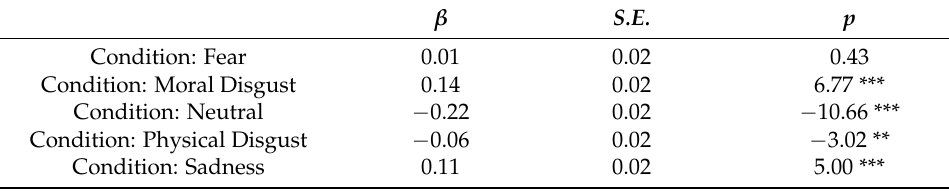
Figure 3. Results of the LMM (Experiment 1). Analyses conducted on the individual discount rates (log k) using the fixed effect of the condition (Anger, Sadness, Fear, Moral Disgust, Physical Disgust, Neutral). Table 4. Results of the LMM, conducted in Experiment 1. Analyses conducted on the individual discount rates (log k) using the fixed effects of the condition (Ager, Moral disgust, Physical Disgust, Neutral).